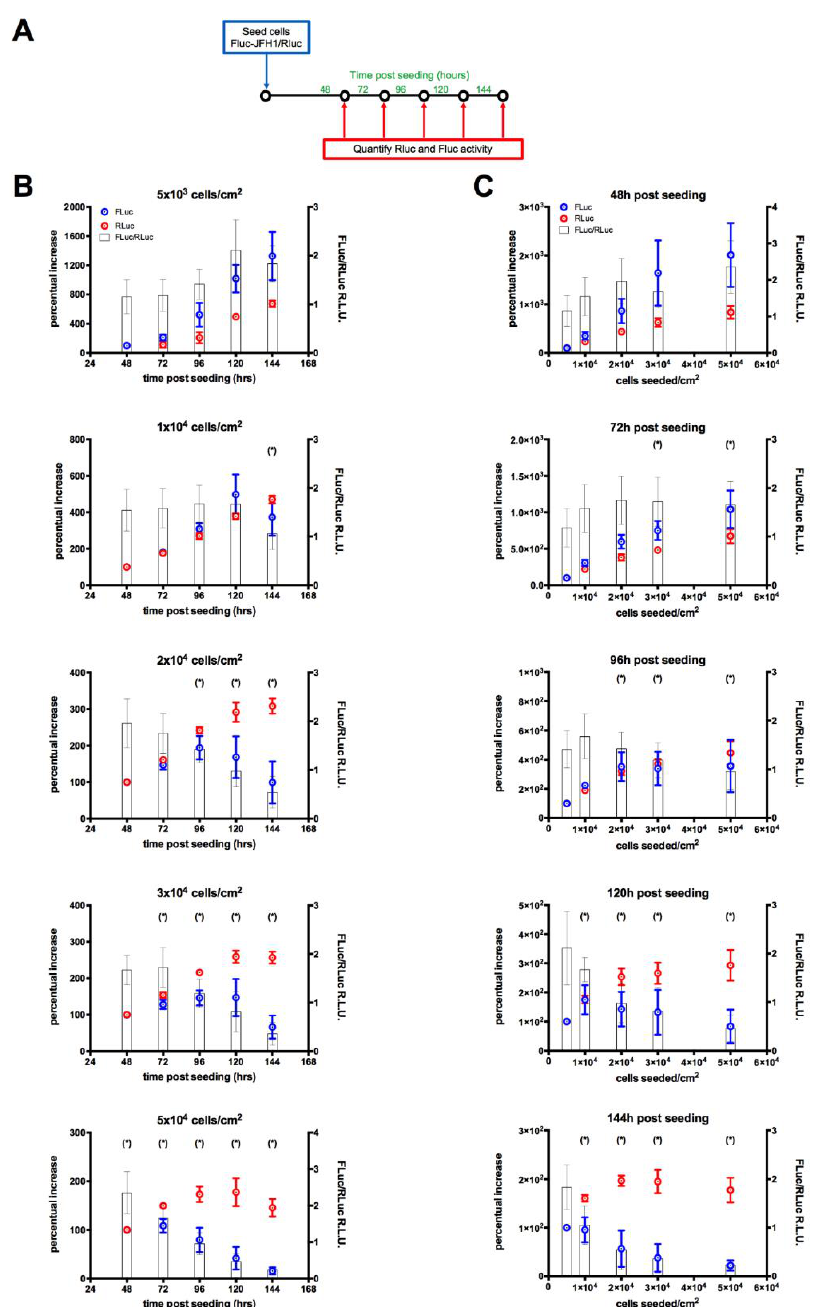
Figure 3. Quantification of cell number and viral replication of a HCV double reporter subgenomic replicon cell line. ( A ). Di ff erent amounts of FLuc-JFH1 / RLuc cells were seeded in 24-well plates and incubated for the indicated time points before being lysed and processed for luminometric detection of RLuc and FLuc signals, allowing to calculate the relative HCV replication as reported by the FLuc / RLuc ratio. ( B ) FLuc (blue circles) and RLuc (red circles) were expressed as the percentage of the signals obtained for the indicated di ff erent times post-seeding and number of cell seeded, relative to 48 h post-seeding, whereas the FLuc / RLuc ratios relative to each condition are shown as white bars. ( C ). FLuc (blue circles) and RLuc (red circles) were expressed as the percentage of the signals obtained at the indicated time point post-seeding and number of cell seeded, relative to 5 × 10 3 cells cm 2 / seeded, whereas the FLuc / RLuc ratios relative to each condition are shown as white bars. Data are mean ± standard error of the mean relative to data repeated in three independent experiments. * = cells